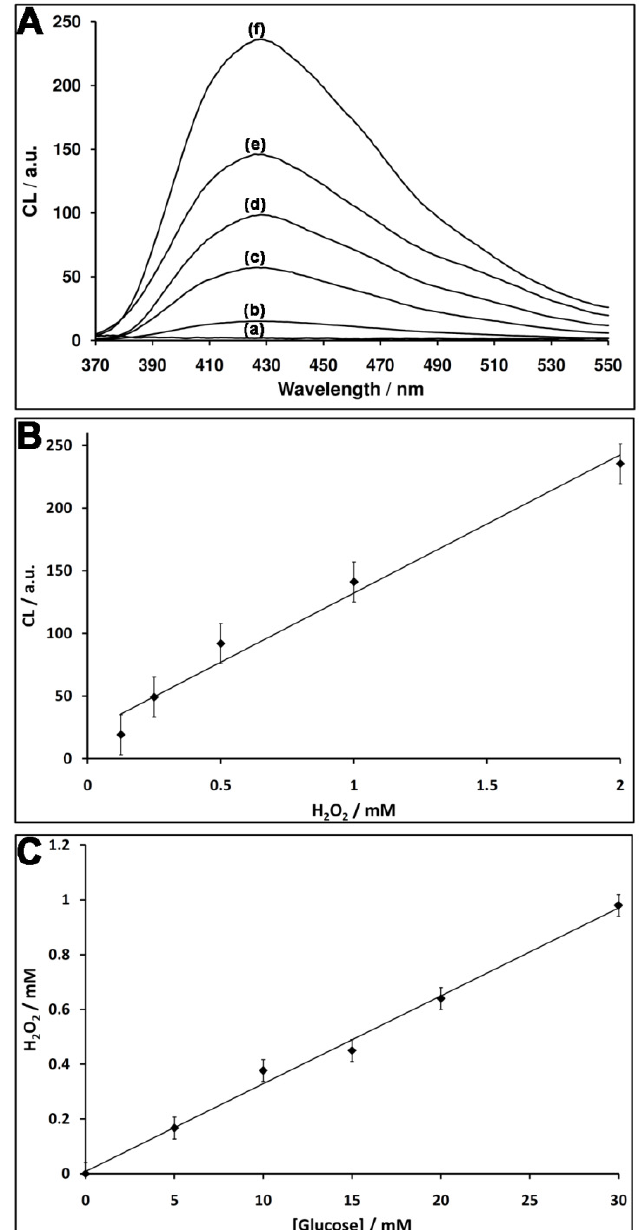
Figure 2. (A) Chemiluminescence light intensities generated by the ( 1 )-modified GOx in the presence of different concentrations of H 0.5 mM (e) 1 mM (f) 2 mM; (B) Resulting calibration curve derived from the increase